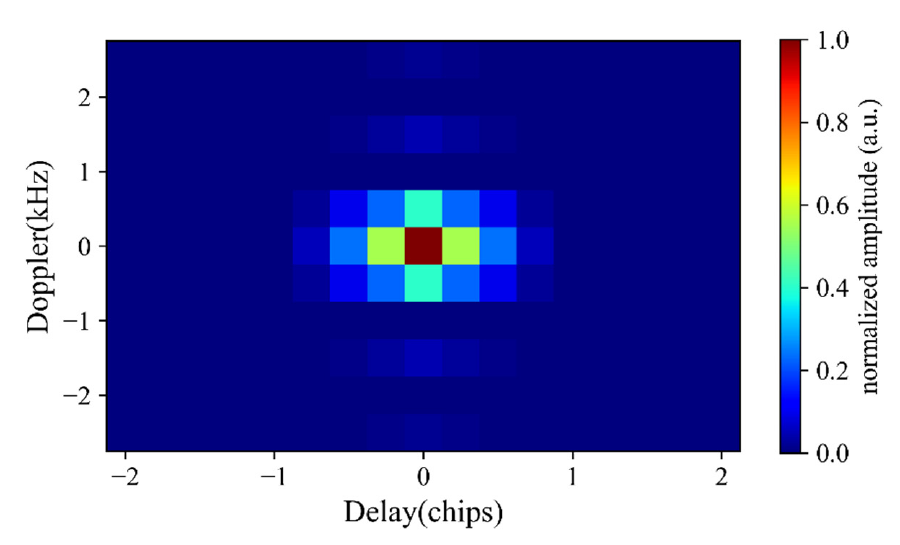
Figure 6. The Woodward ambiguity function in the same delay-Doppler domain as in Figure 5. For the determination of the C horseshoe , we chose the 6 × 7 delay-Doppler region as shown in Figure 5. The power of incoherent DDMs mainly spread in the specific region (e.g., Figures 3a and 4d), which approximately consists of a 5 × 3 peak region C peak and a 6 × 7 delay-Doppler region. The power spread outside this region is very limited, so we keep seven bins along the Doppler domain for C horseshoe and exclude the first and last two bins to increase the sensitivity of PHPR to the coherence reflection. The last column of Table 1 shows the PHPR of the four DDMs. We can see that the PHPR of DDM (a) from inland water is significantly larger than that of the other three DDMs, indicating that the new method has much higher sensitivity to the inland water than the DPSD